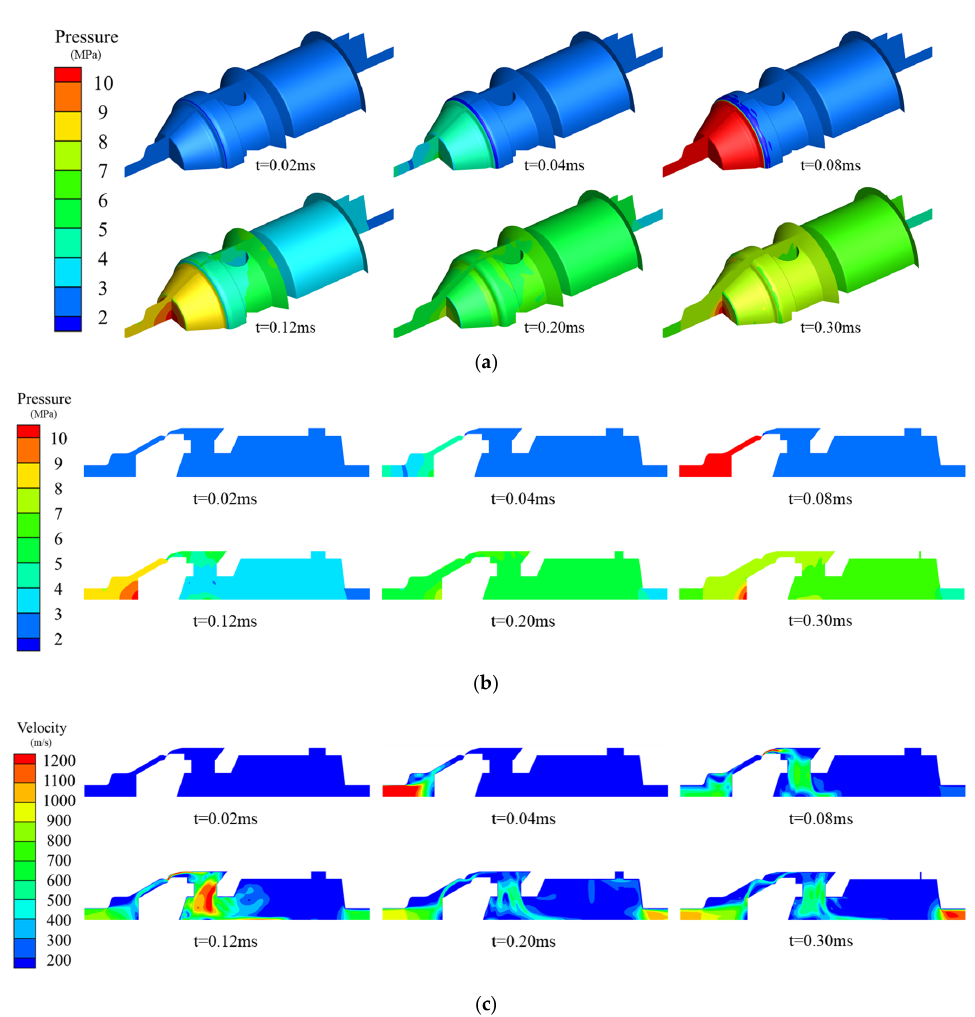
Figure 10. Static pressure and velocity distributions at different moments: ( a ) Static pressure contours for the symmetrical plane and valve spool surfaces; ( b ) Static pressure contours for the symmetrical plane; ( c ) Velocity contours for the symmetrical plane.